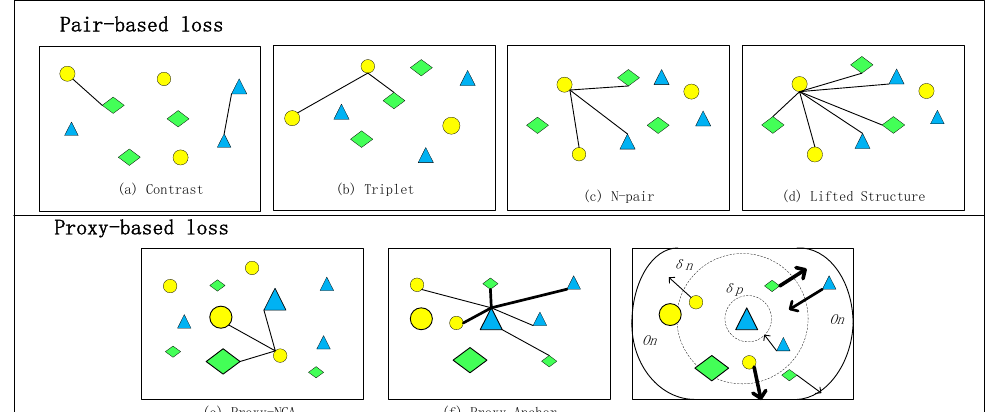
Figure 1. The structure diagram of the pair-based loss and the proxy-based loss is given in the figure. The graphs with different colors and shapes represent samples of different categories, among which the slightly smaller ones are actual sample points, and the slightly larger ones represent proxies of corresponding categories. Lines connecting different shapes represent pairs of samples that need to be constructed for training. The thicker lines represent greater optimization degree. The arrows point to the optimization direction, and the dotted circles represents the threshold ranges. The arc of the real lines represents the location of the optimal value O n , optimized for dissimilar samples. ( a ) Contrast loss [12] uses two samples to construct a sample pair. ( b ) Triplet loss [13] using a sample as the anchor, and a triplet is constructed by selecting both the same kind of positive sample and a different negative sample. ( c ) N -pair loss [15] and ( d ) lifted structure loss [14] construct tuples with more samples, but do not make use of all samples in the batch. ( e ) Proxy-NCA loss [21] associates each sample with proxies, but it does not explore the relationships between samples. ( f ) Proxy anchor loss [24] selects a proxy as an anchor and associates it with other samples. ( g ) Our DHPL loss is based on the proxy anchor and different optimization conditions are considered in DHPL